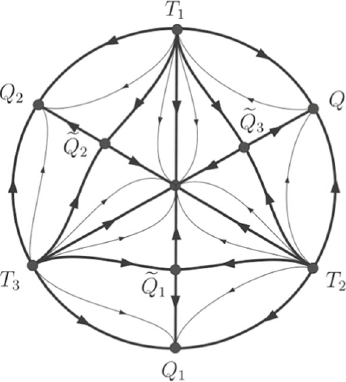
Fig. 3 The phase portrait in the Kasner disc ( (cid:2) ≤ 1) for − 1 / 3 < w < 1 / 3. There are separatrices splitting the dynamics in two main global behaviors. In the innermost part, the solutions isotropize towards the FLRW universe at late times. In the outermost one, the universes tend to the highly anisotropic LRS models at the Q -Taub points. As we get closer to the radiation epoch (w → 1 / 3 − ), anisotropization starts to dominate over isotropization